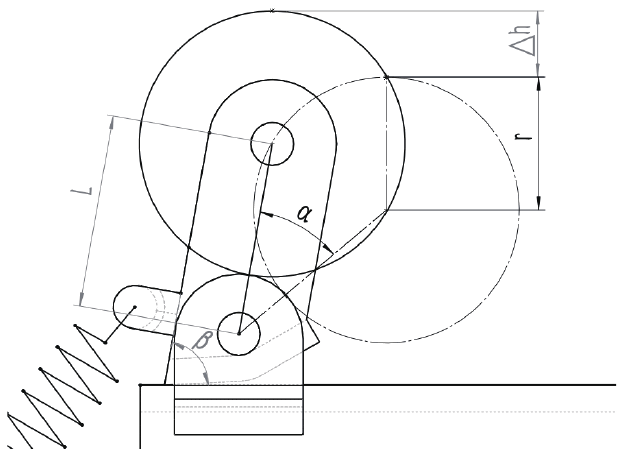
Figure 5. Schematic of the pipeline size’s adaptive